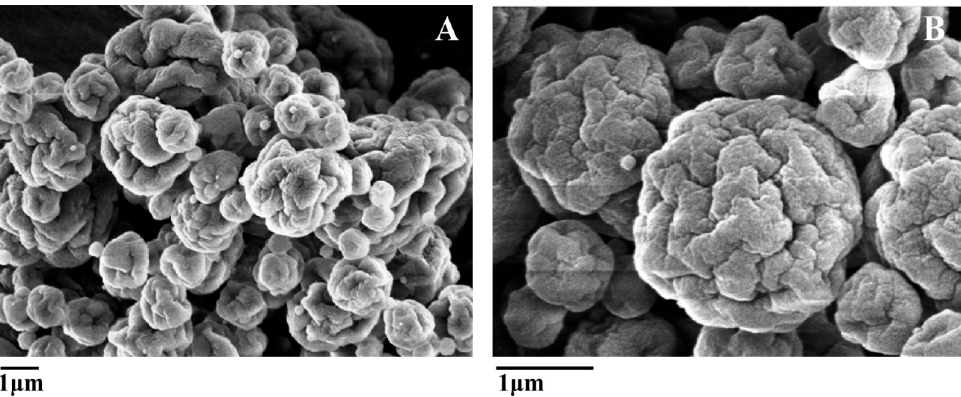
Figure 1. SEM of loaded microcapsules cross-linked with TPP. Sample A3 ( A ) and Sample A5 ( B ).